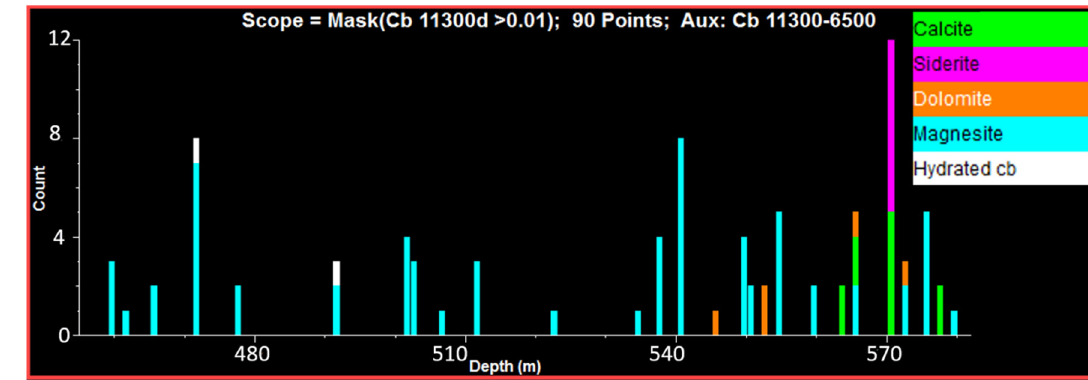
Figure 18. Carbonate abundances from HyLogger TM scanning of DDH TCGA-01, showing magnesite (aqua) as generally dominant, with other species including dolomite (orange), calcite (green), and, notably, siderite (magenta) becoming more common approaching the bottom of the drill hole.